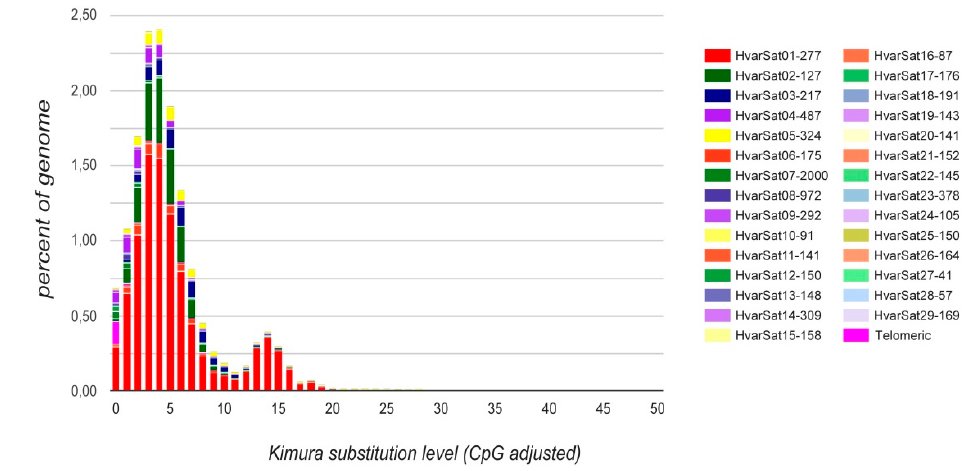
Figure 4. Satellitome landscape of the satDNA families in Hippodamia variegata .